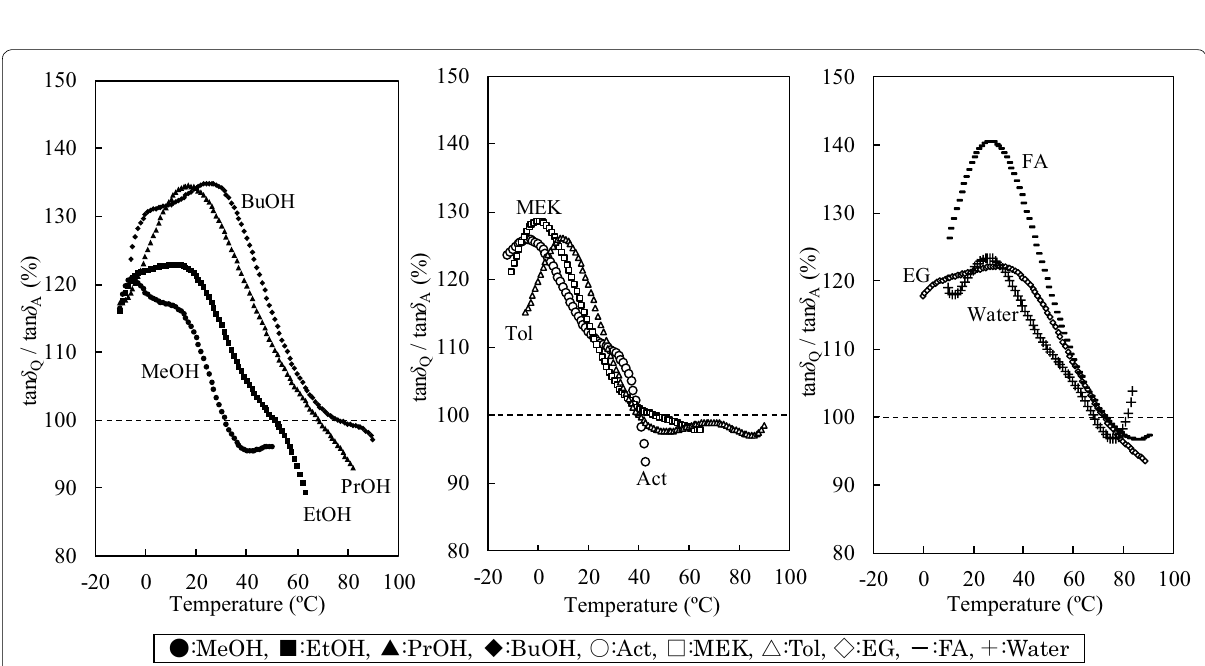
related to the glass transition temperature of lignin. In Fig. 3, the peak temperature of the tan δ was lower in the acetylated samples swollen by alcohols and higher